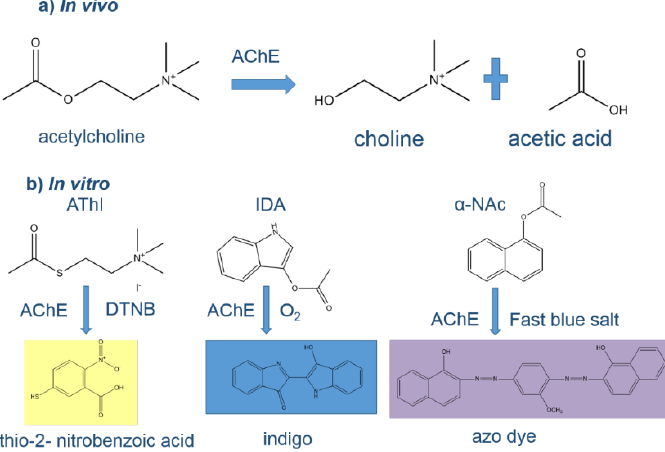
Figure 1. ( a ) In vivo, the neurotransmitter acetylcholine is hydrolyzed to choline and acetic acid by AChE; ( b ) in vitro hydrolysis of various substrates (acetylthiocholine iodide (AThI, Ellman’s assay substrate), indoxyl acetate (IDA) and α -naphthyl acetate ( α -NAc)) by AChE producing di ff erent colored